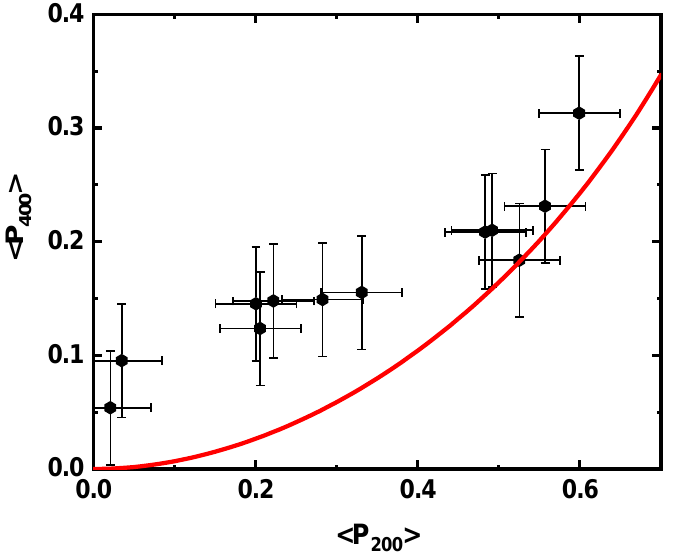
Figure 7. The values of ⟨P 400 ⟩ plotted as a function of ⟨P 200 ⟩ compared to the theoretical predic- tion of Maier – Saupe theory (red line). A clear deviation can be seen at higher strain (lower ⟨P 200 ⟩ and ⟨P 400 ⟩ values) .